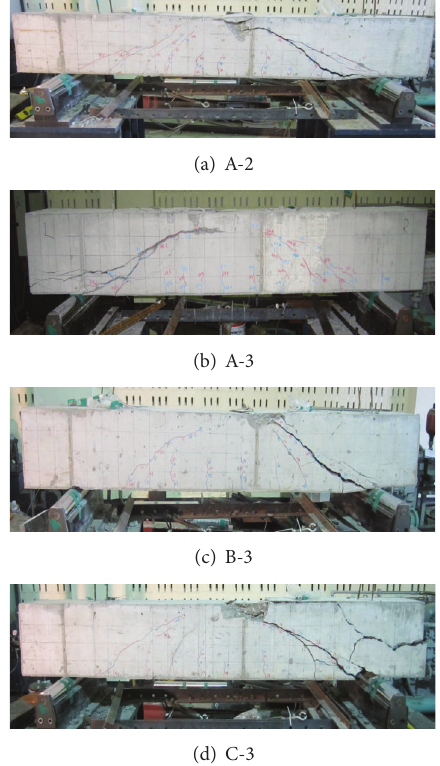
Figure 8: Shear-compression failure in specimens.